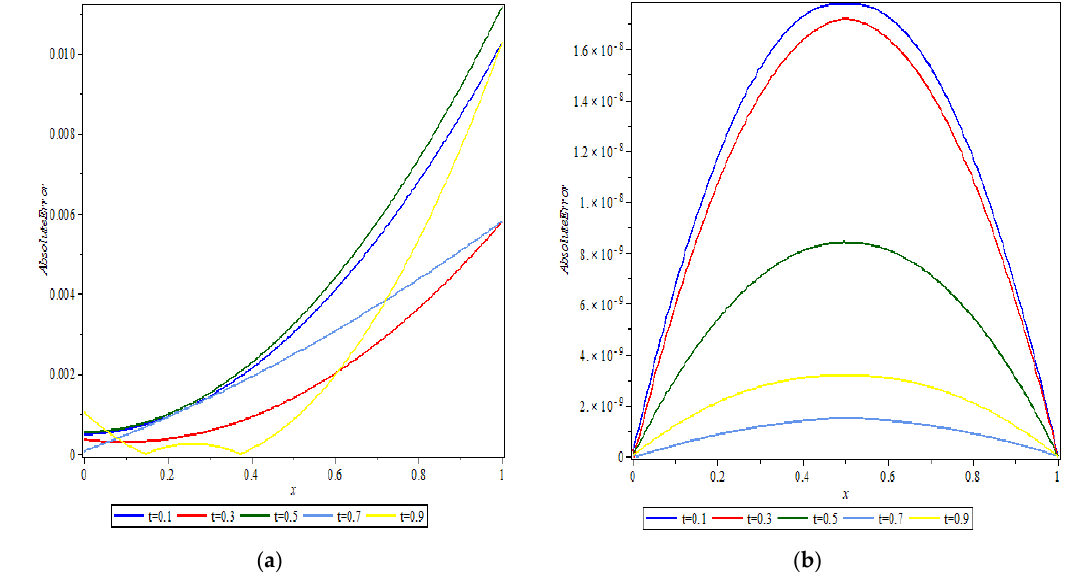
Figure 3. ( a ) The absolute errors